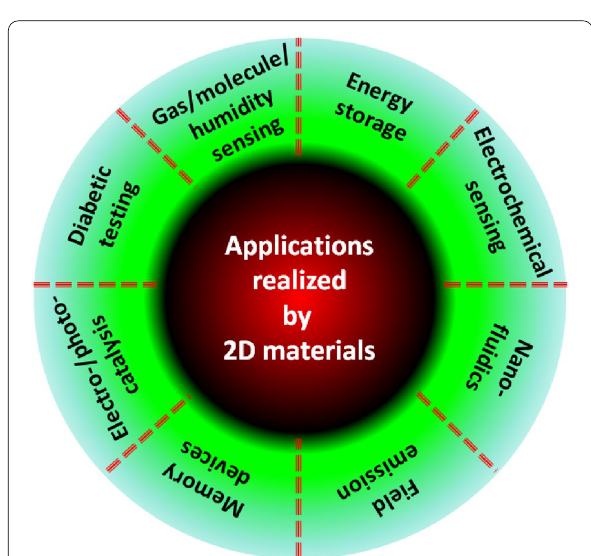
Fig. 11 Applications are already realized by 2D materials, doped 2D materials, and their hetero